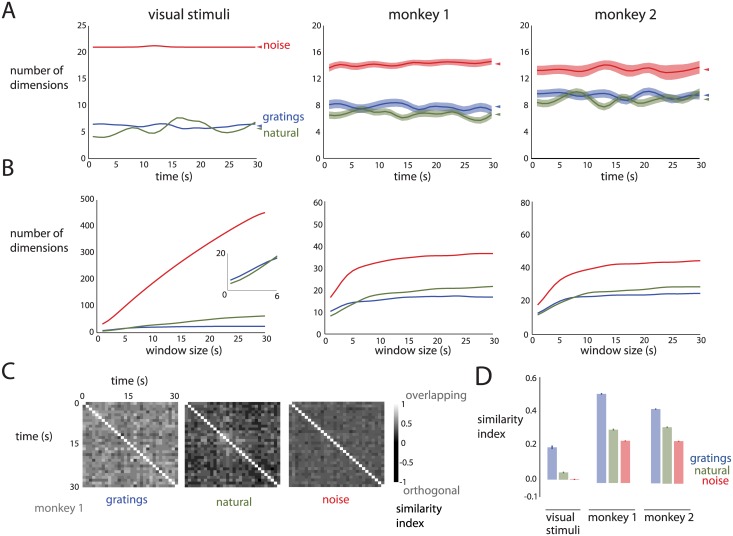
Time-resolved dimensionality of movie stimuli and population responses.A: Dimensionality versus time. Left panel: visual stimuli. Center panel: monkey 1 (61 neurons). Right panel: monkey 2 (81 neurons). Error bars are standard deviations of subsampled estimates. Triangles denote mean dimensionality across time for each movie. Curves were smoothed with a Gaussian kernel with a standard deviation of 1.5 s. B: Dimensionality with growing time windows starting at the beginning of each movie. Left panel: visual stimuli. Inset: zoomed portion of the bottom-left of the plot. Center panel: monkey 1. Right panel: monkey 2. Curves were smoothed as in A. Due to the smoothing, the dimensionalities for the 1 second window do not exactly match the leftmost point in A, and those for the 30 second window do not exactly match the dimensionalities in Fig 3. C: Similarity of the basis patterns employed by the population responses across time (monkey 1). Each element in the similarity matrix corresponds to the similarity index between the sets of patterns for a pair of time points. D: Mean similarity index for visual stimuli and population responses. Error bars denote standard error over similarity indices.